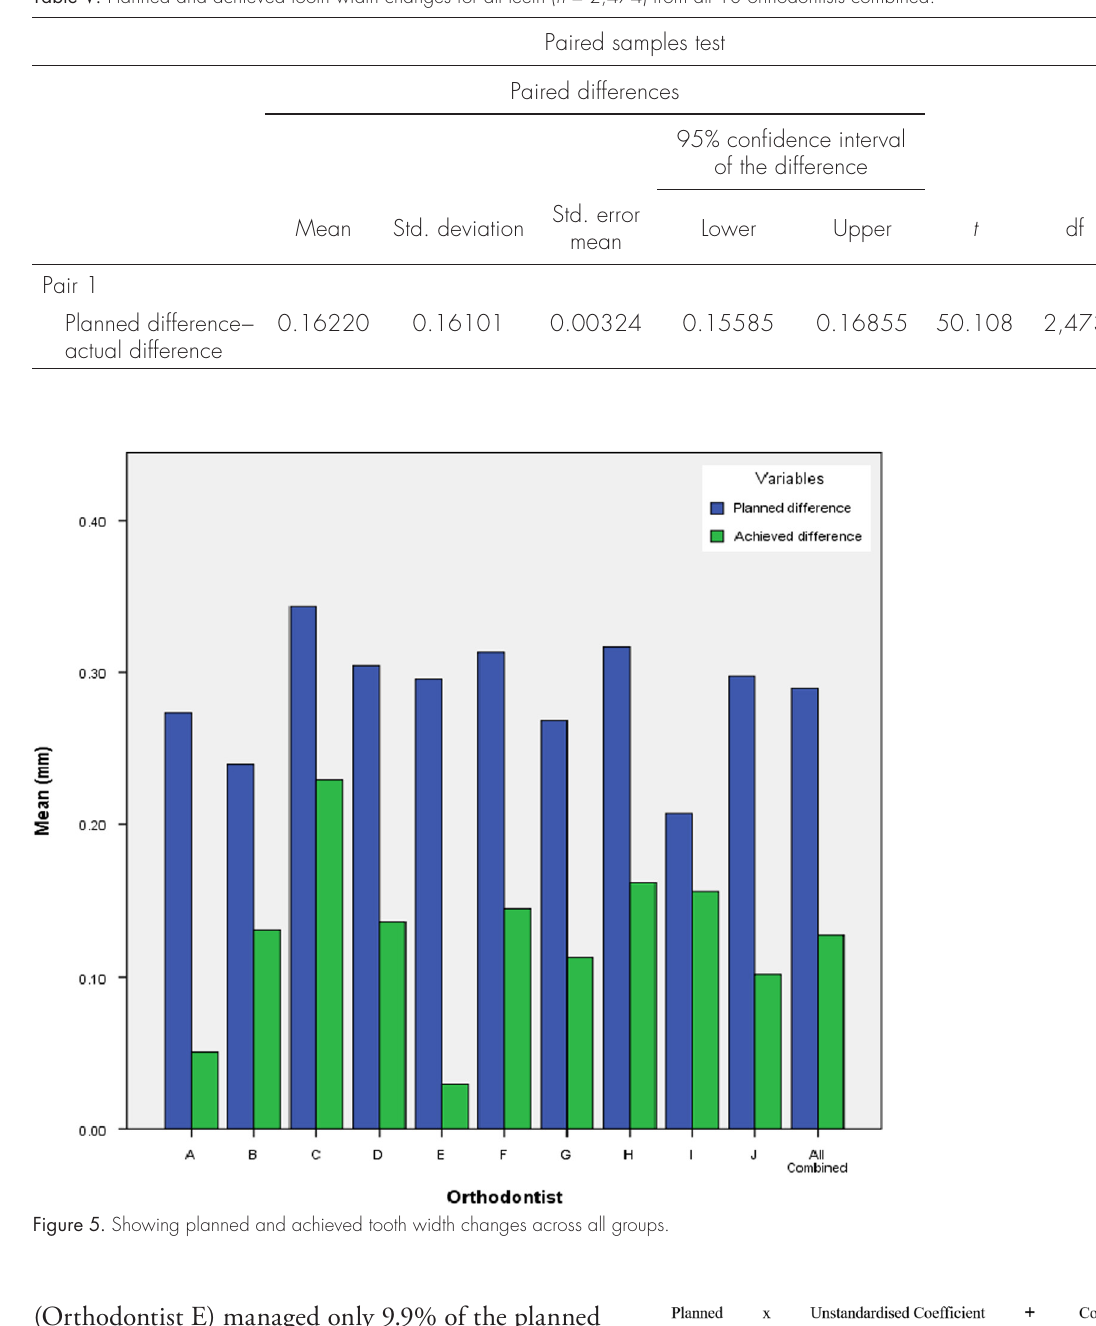
Table V. Planned and achieved tooth width changes for all teeth ( n = 2,474) from all 10 orthodontists combined.